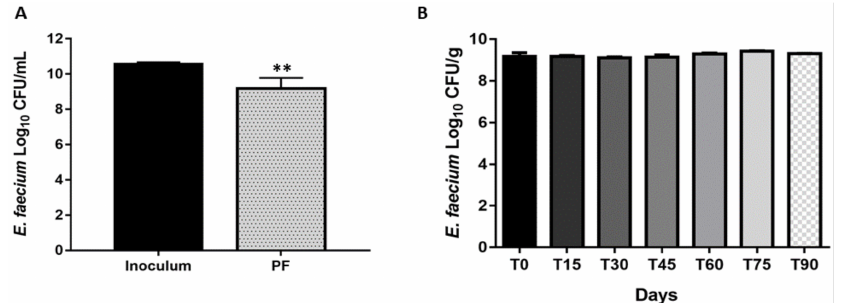
Figure 2. Probiotic resistance. ( A ) Probiotic viability in the inoculum and in PF (Probiotic Film) after drying, according to t -test (** p = 0.002). ( B ) Probiotic viability during storage, according to ANOVA followed by Tukey’s test.